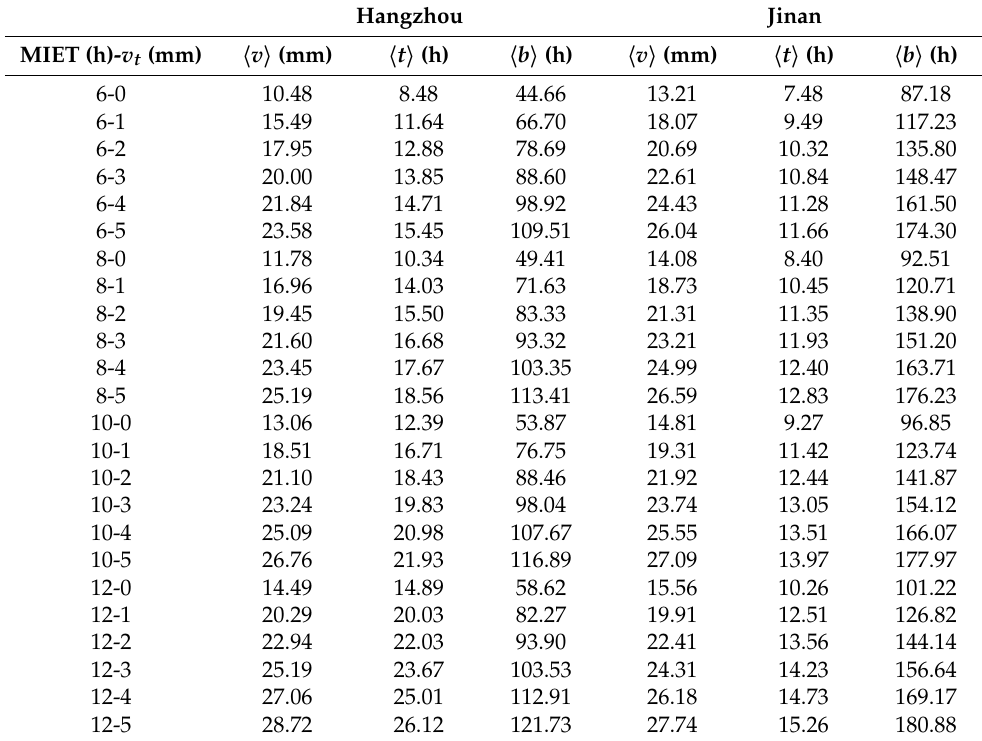
Table 3. Rainfall event characteristics with different pairs of MIET and v t for Jinan and Hangzhou. Hangzhou